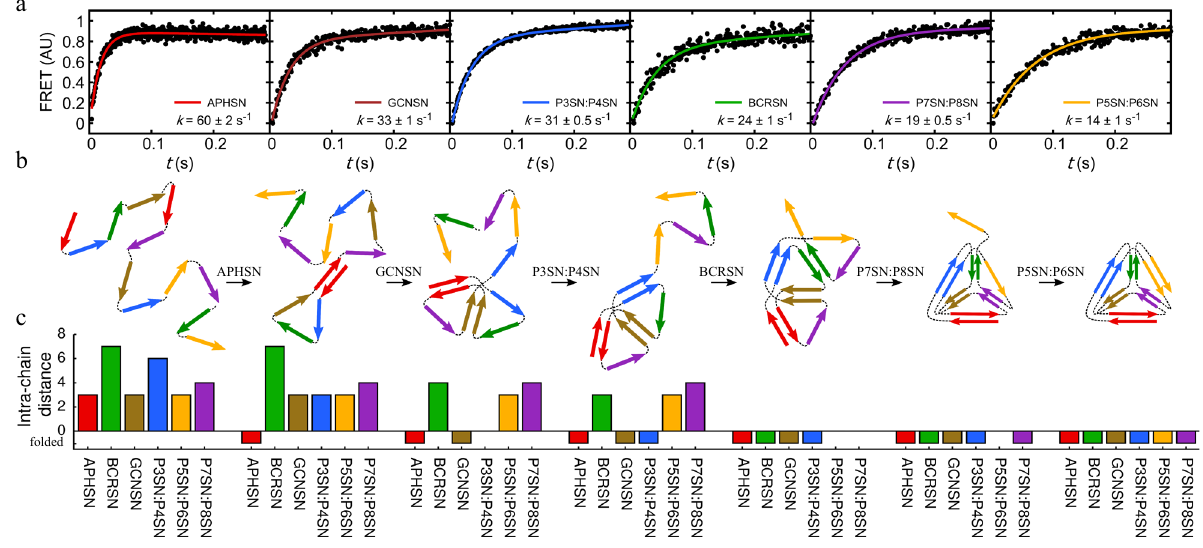
Fig. 2 Stepwise modular folding mechanism of CCPO tetrahedron TET12SN. a The order in which individual CC edges in the tetrahedral cage assemble was determined by comparing normalized time-resolved increase in acceptor fl uorescence during refolding of TET12SN in 2 M Gdn-HCl observed for each of the different fl uorescent dye placements. In each experiment, a pair of fl uorescent dyes was conjugated to the appropriate pair of cysteine residues in the selected CC dimer allowing the folding of one edge of the tetrahedral cage to be tracked. Increase in Förster resonance energy transfer (FRET) was fi t using a two-state kinetic model. FRET intensity is given in arbitrary units (AU). b Scheme of the proposed stepwise folding mechanism of TET12SN based on stopped- fl ow results shown in ( a ). c Changes in the effective intra-chain distance between peptide pairs during folding. In each step, one of the peptide pairs characterized by the shortest intra-chain distance formed. Source data are provided as a Source Data fi